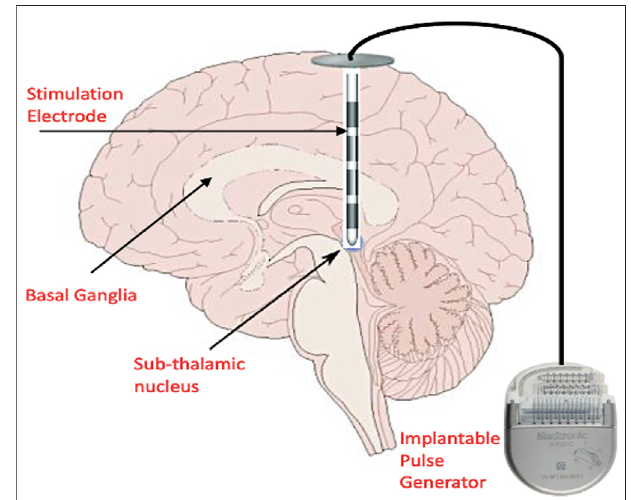
FIGURE 2 | Conventional DBS setup showing the placement of the stimulation electrodes in the basal ganglia and sub-thalamic nucleus. The Implantable Pulse Generator (IPG) is placed in the sub-clavicular space, and extension wires are tunneled subcutaneously to connect the intracranial electrodes and IPG. The IPG is programmed remotely by the physician. (This fi gure indicates only cortical biomarkers and is a simpli fi ed diagram).